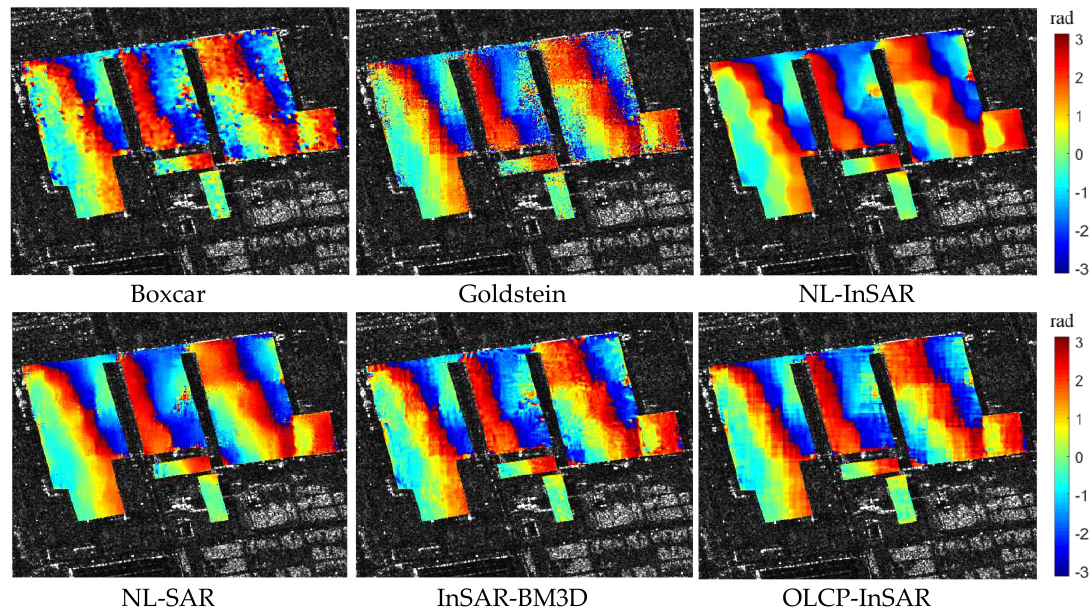
Figure 18. The filtered result of the first slice in the real InSAR tensor acquired by the filter operating on the matrix model.